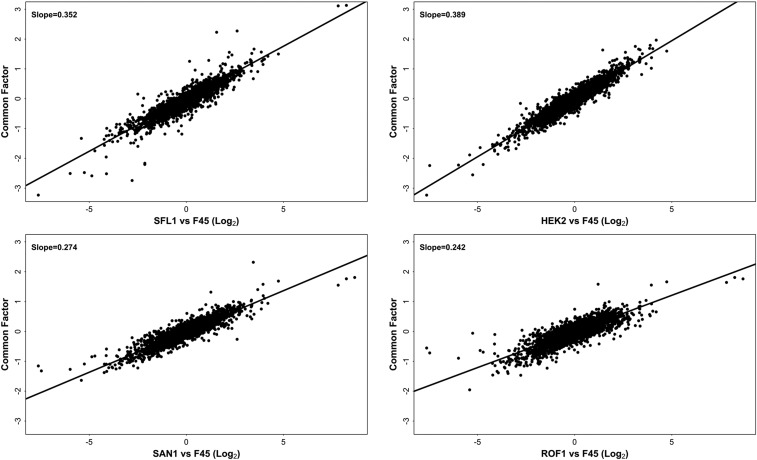
SFL1, HEK2, SAN1, and ROF1 overexpression profiles (relative to F45) vs. the common factor, showing linear regression line and slope.